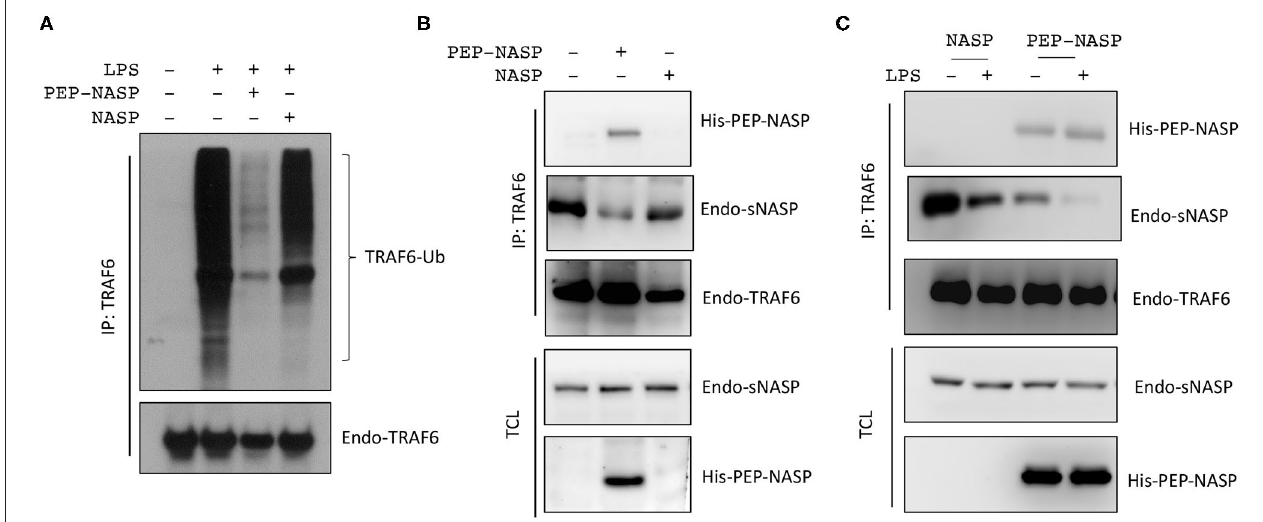
FIGURE 3 | The PEP-NASP significantly inhibits tumor necrosis factor receptor-associated factor 6 (TRAF6) polyubiquitination in LPS-stimulated RAW 264.7 cells. (A) Cells were pretreated with or without the PEP-NASP or NASP (0.4 µ M) for 1h before the addition of LPS (1 µ g/mL) for 30min. Cell lysates were immunoprecipitated with an anti-TRAF6 followed by immunoblotting (IB) with an antibody against Ub or TRAF6. (B) Immunoprecipitation (IP) of endogenous TRAF6 (with anti-TRAF6) from RAW 264.7 cells transduced with the PEP-NASP or NASP, followed by IB with an antibody against His, NASP, or TRAF6. Total cell lysate (TCL) IB was done with anti-NASP and anti-His. (C) Cells were transduced with the PEP-NASP or NASP, stimulated with LPS, and assessed by IB with an antibody against His, NASP, or TRAF6 after IP with anti-TRAF6 or by IB with anti-NASP and anti-His in TCL. Data represent a minimum of three independent